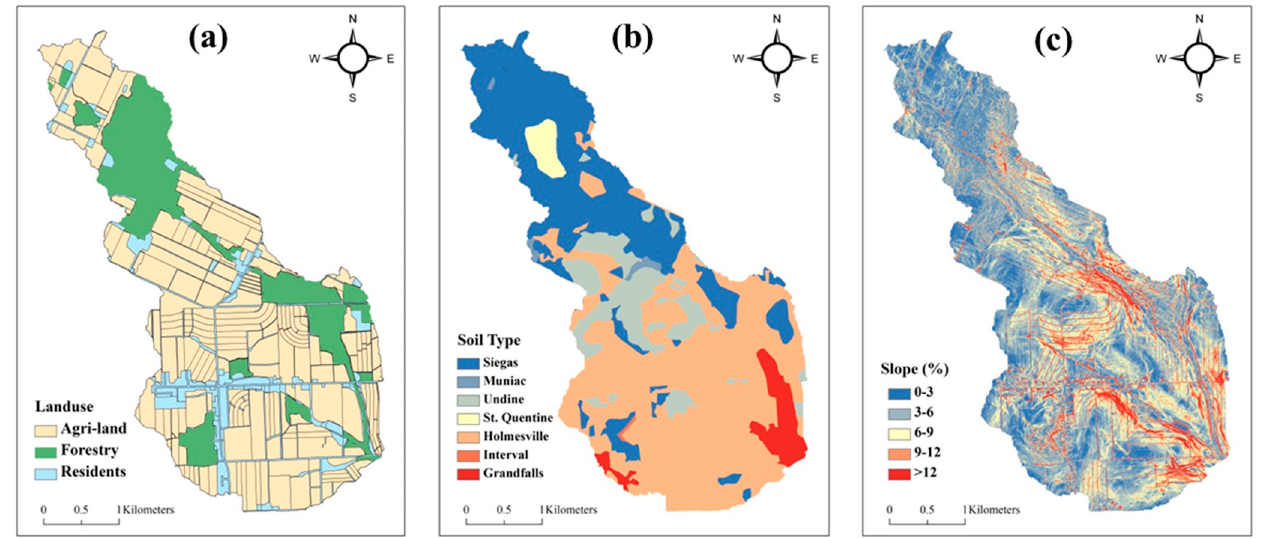
Figure 2. ( a ) Land use map, ( b ) soil map, and ( c ) slope classes created using a 1-m LiDAR DEM for the BBW.